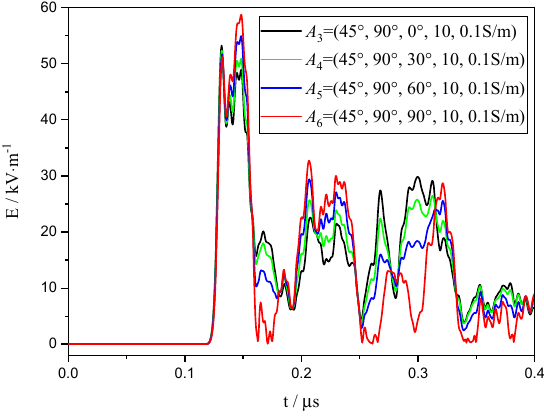
Figure 9. Prediction of electric field with polarization angle.